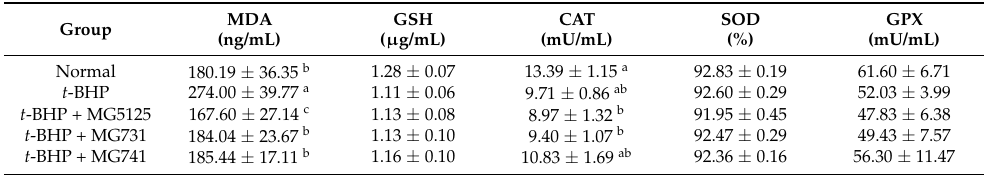
Table 2. Effect of probiotics on hepatic malondialdehyde (MDA), glutathione (GSH), catalase (CAT), superoxide dismutase (SOD), and glutathione peroxidase (GPx) levels in t -BHP-induced C57BL/6 mice.